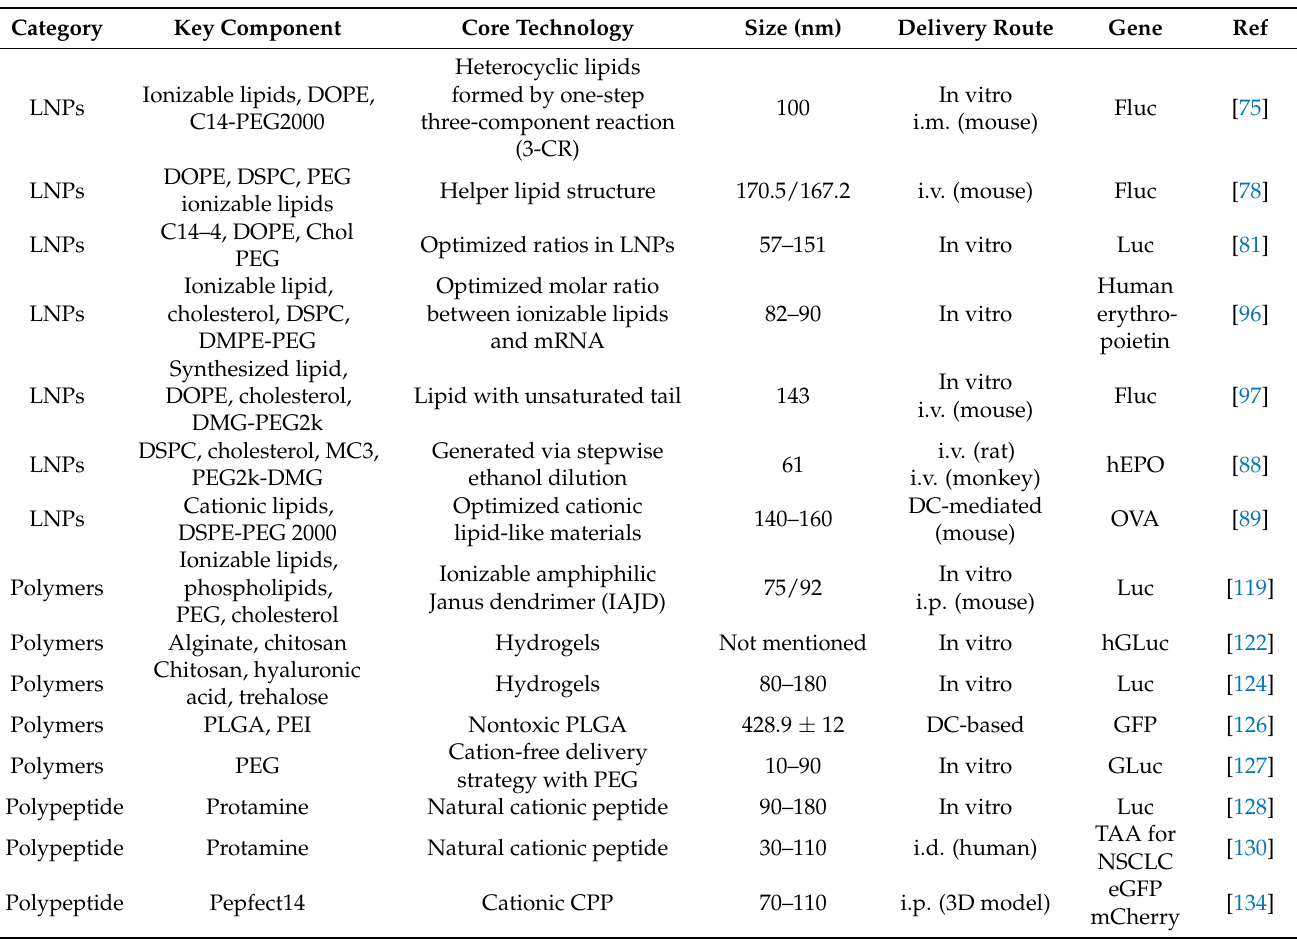
Table 2. Some nonviral nanosystems for mRNA delivery in Section